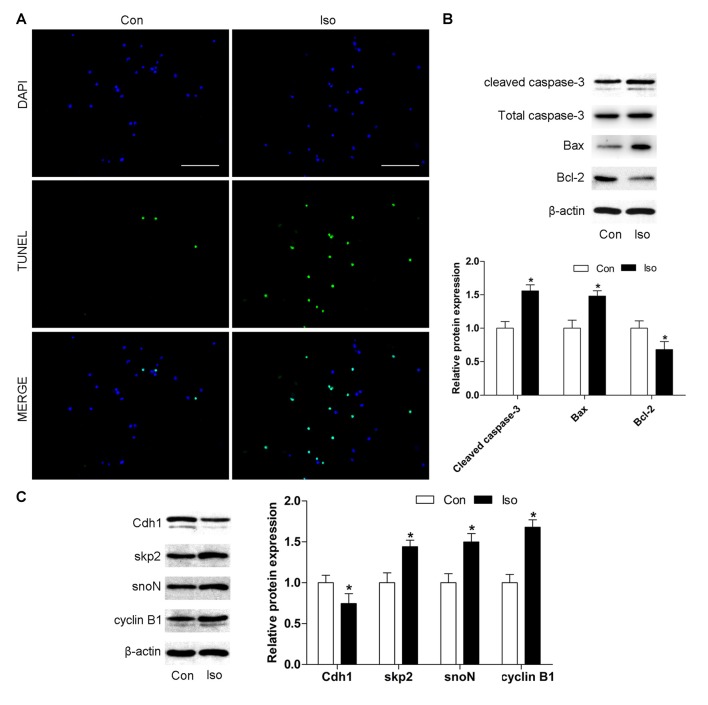
Cdh1 is downregulated during isoflurane-induced neuronal apoptosis in vitro. Cultured neurons were treated with 95% O2 and 5% carbon dioxide (CO2) in the absence or presence of 2% isoflurane for 6 h on day 7 in vitro (7 DIV). (A) Representative images of cultured neurons are shown after incubation with TUNEL reaction solution. Cells labeled in green are positive for apoptosis; blue, nucleus. Scale bar = 100 μm. (B,C) The level of pro-apoptotic proteins (cleaved caspase-3 and Bax) and anti-apoptotic protein Bcl-2 was detected by western blotting. In addition, Cdh1 and its downstream substrates (skp2, snoN and cyclin B1) were also assessed by western blot analysis. Quantification of these proteins is shown. Data are presented as mean ± SEM. *P < 0.05 vs. control group.